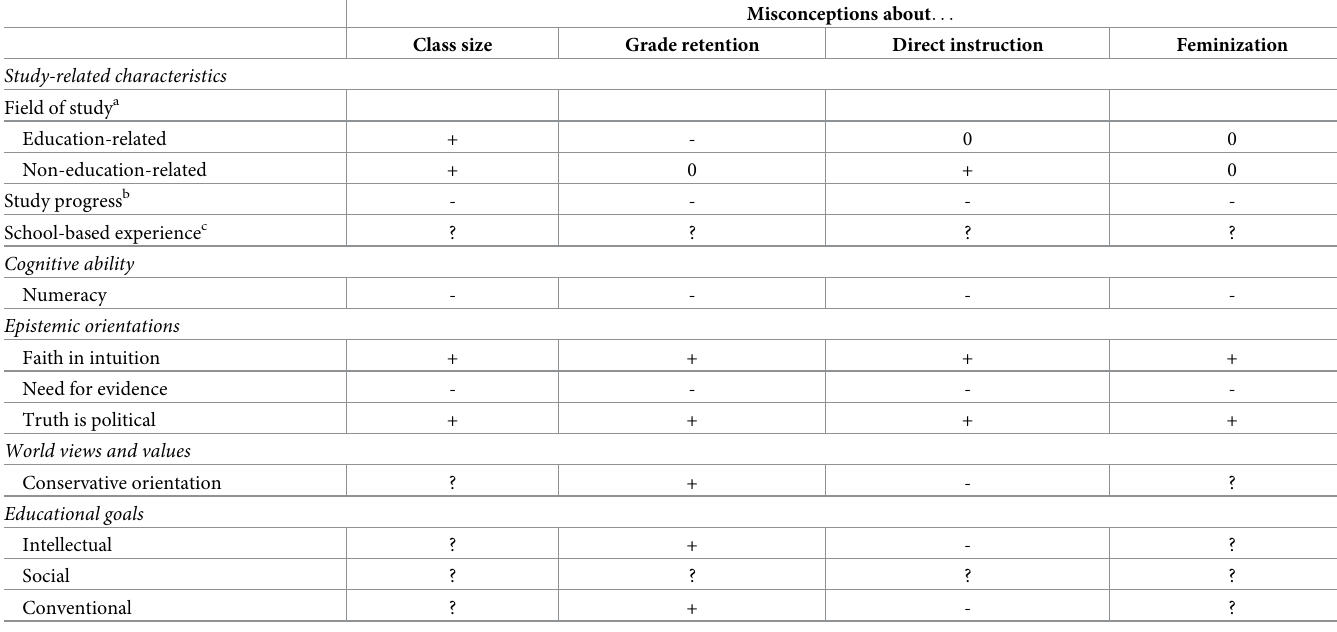
Table 1. Summary of the preregistered hypotheses.